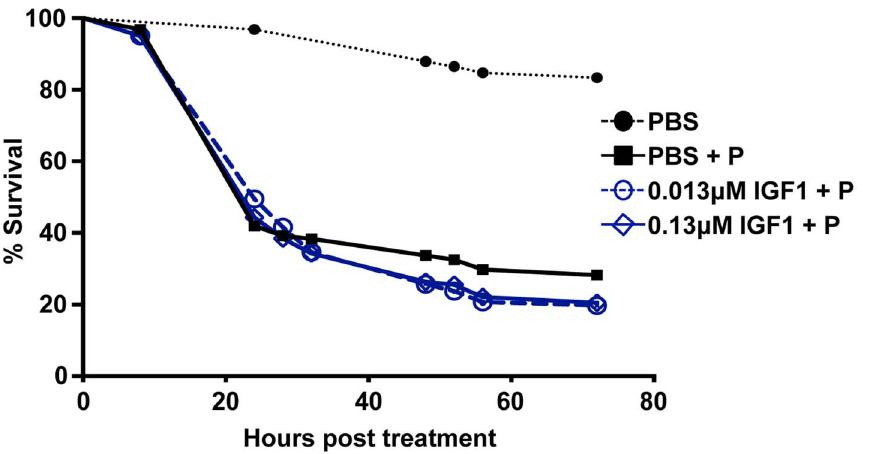
Figure 7. Effect of low dose IGF1 on A.stephensi survivorship was ablated by enhanced oxidative stress. Mosquitoes were fed saline/ ATP supplemented with: (1) low (0.13 m M) IGF1 or high (0.13 m M) IGF1 and 1 mM paraquat (P), (2) an equivalent volume of PBS and 1 mM paraquat (PBS + P), or (3) an equivalent volume of PBS without paraquat (PBS 2 P) as an untreated control. Dead mosquitoes were removed and counted at intervals between 8 h and 72 h. The experiment was replicated twice with separate cohorts of mosquitoes. Survival analyses were performed using the Kaplan Meier method and differences between survival curves calculated using the Wilcoxon test. Survival curves for 0.13 m M IGF1 + P and 0.13 m M IGF1 + P were not significantly different from each other and neither was significantly different from PBS + P (p . 0.05). Survival curves for low IGF1 + P, high IGF1 + P, and PBS + P, however, were significantly different from the untreated control PBS 2 P (p , 0.05).